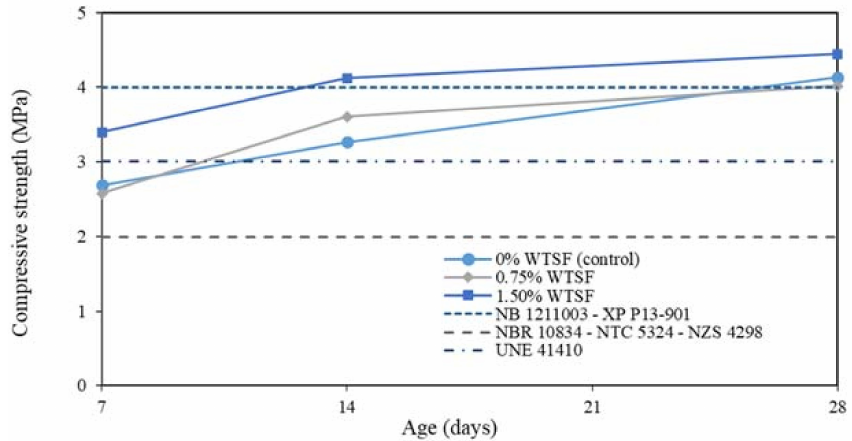
Figure 8. Block compression tests